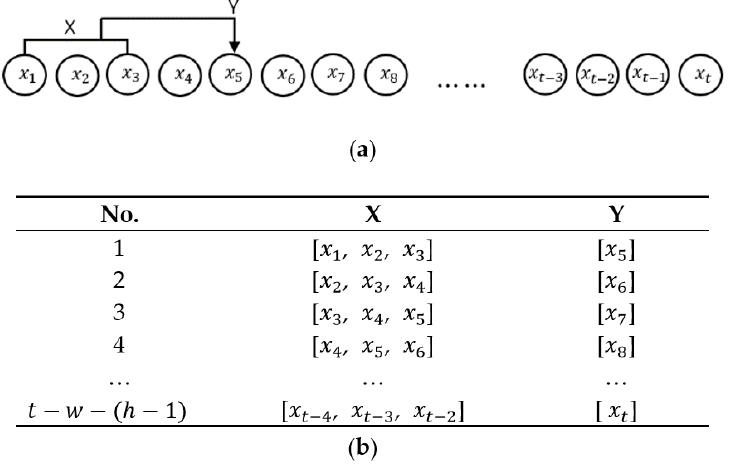
( b ) Representation of feature vector X and label Representation of feature vector X and label Y.